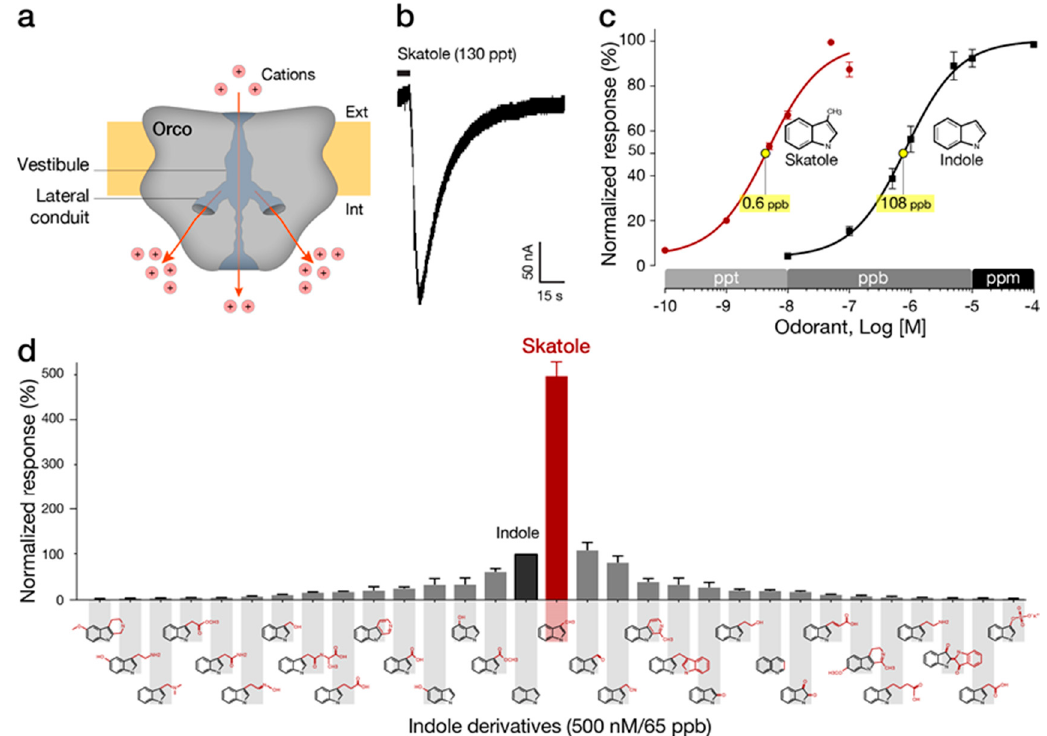
Figure 2. The mosquito OR9 is a supersensitive and specific skatole receptor. ( a ) The ion conduction pathway of the Orco homotetramer (two lateral conduits are shown). ( b ) The novel mosquito skatole receptor (OR9) exhibit fast and robust responses to skatole. ( c ) OR9 detects skatole in the ppt (parts per trillion) range. ( d ) OR9 is highly selective to skatole in the low ppb (parts per billion) range. See Ruel et al., 2019 [55] for additional information.